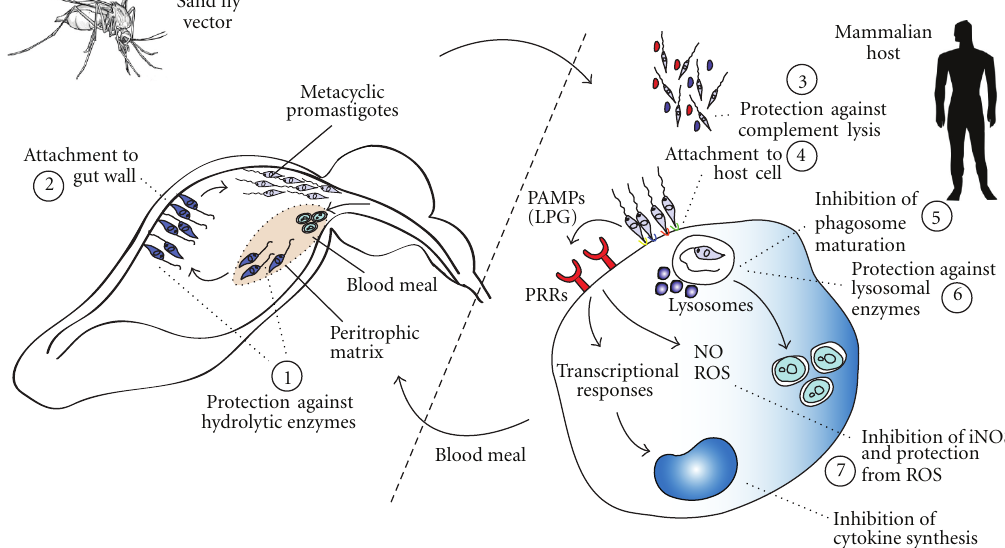
Figure 2: Role of LPG in Leishmania infectivity and virulence. Shown are putative and bona fide actions of Leishmania spp. LPG molecules in subversion of host and vector functions. These LPG functions include (1) physical protection to promastigotes against hydrolytic enzymes in the digestive tract of insect; (2) attachment of promastigotes to the gut wall; (3) In the mammalian host, promastigotes protection against lysis by complement proteins; (4) attachment of parasites to the macrophage membranes or alternative transiently infected cells, such as neutrophils, dendritic cells and perhaps others; (5) transient impairment of the phagosome maturation; (6) physical protection against degradation by lysosomal enzymes; (7) modulation of macrophages activation through impairing the synthesis of nitrogen species and cytokines related to the control of infection and protection from